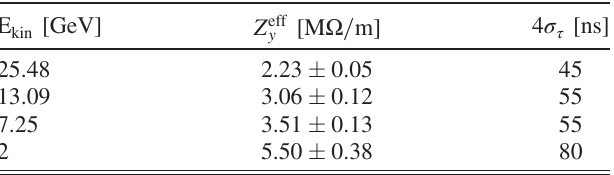
TABLE III. Indirect space charge and resistive wall vertical effective impedance expressed in M Ω = m, calculated for different kinetic energies for a round chamber of 35 mm radius and 39 mm